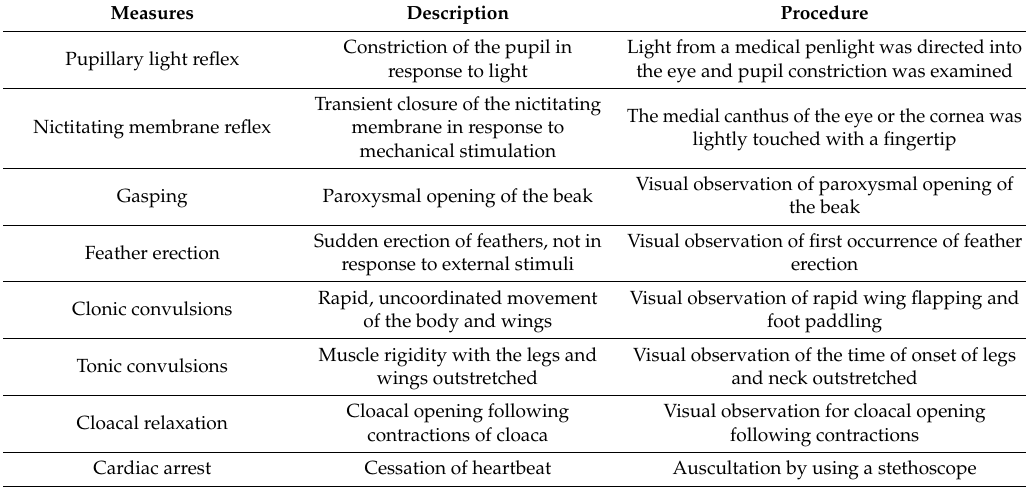
Table 2. List of antemortem assessment measures, description, and procedure use recorded in order of observation after application of each killing method